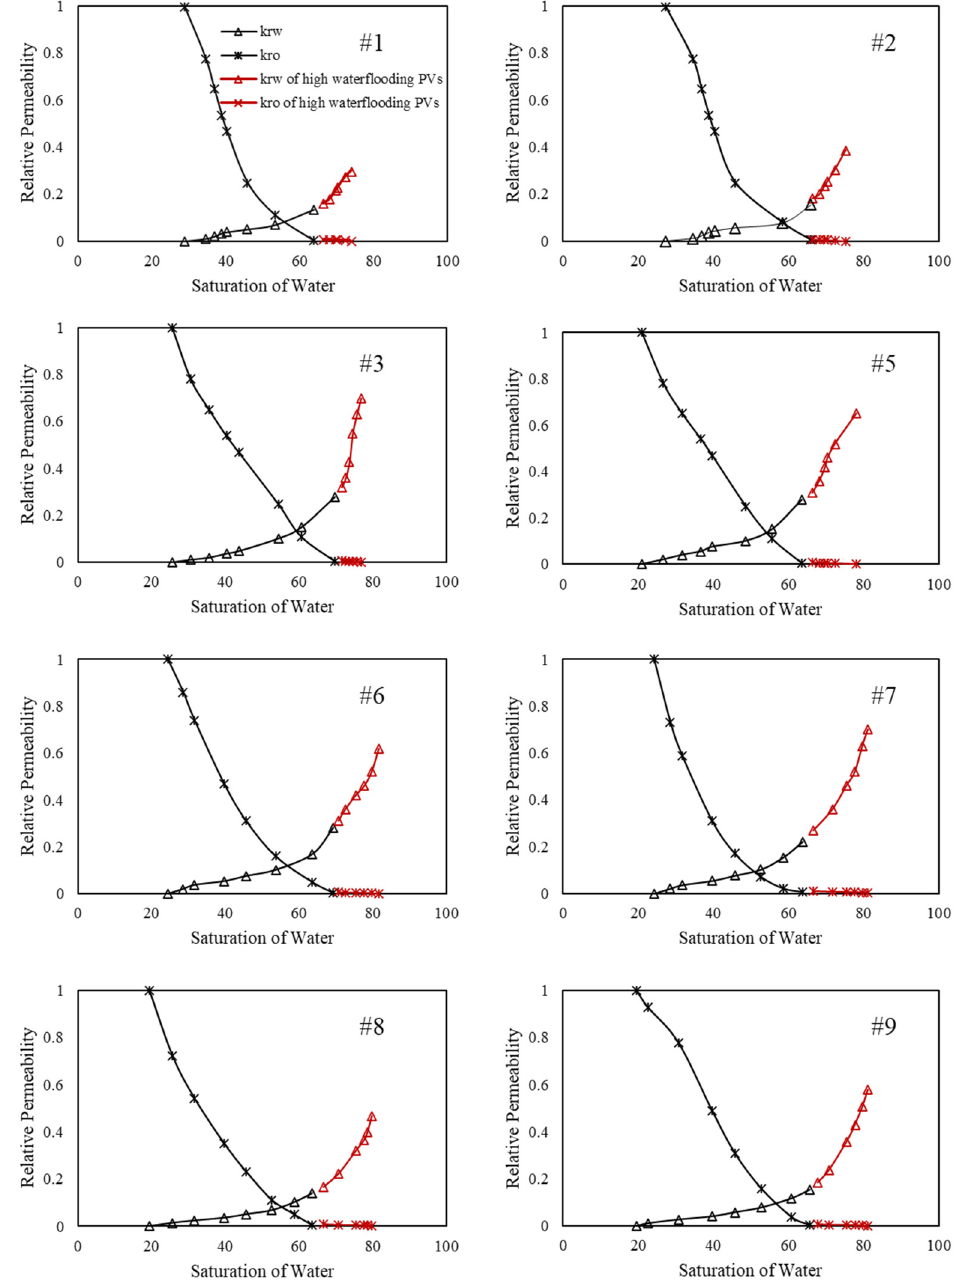
Figure A1. High waterflooding PVs’ relative permeability curves of other cores.